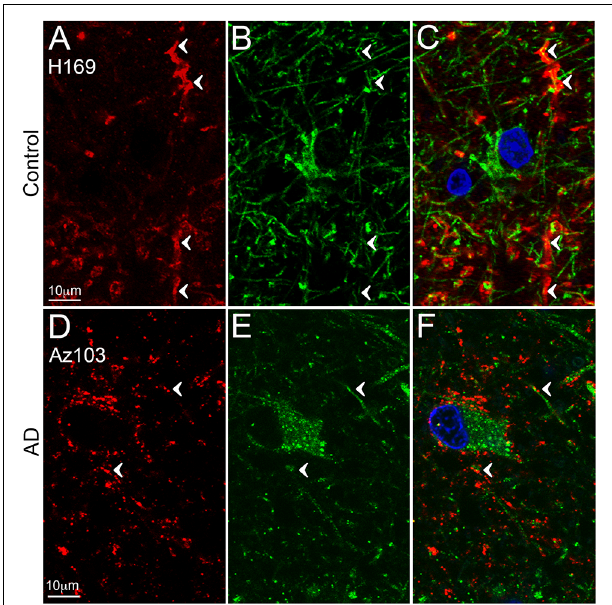
FIGURE 3 | EAAT2 expression in the dentate gyrus. Photomicrographs of the stratum moleculare of the denate gyrus showing EAAT2 ( A,D , red), GFAP ( B,E , green) and EAAT2 overlaid with GFAP (C,F) immunoreactivity for a representative control ( A,B , H169) and Alzheimer’s disease (AD) ( D–F , Az103) case. EAAT2 labeling is mainly localized to membranes of astrocytic stem and fine branches, and soma, while GFAP staining is observed in the cytoplasm of the branches and soma ( A–F , arrowheads). Cell nuclei are labeled with Hoechst nuclei counterstain ( C,F , blue). Scale bar (A–C) = 10 µ m.